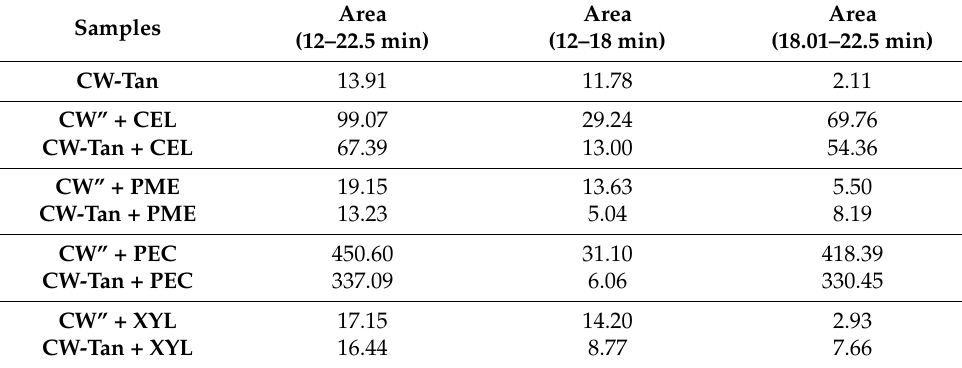
Table 6. Total area, height and medium molecular mass polysaccharides (those eluting from 12 to 18 min) and low to medium molecular mass polysaccharides (eluting from 18.1 to 22.5 min) measured in the size exclusion chromatography analysis for the polysaccharides liberated from the cell walls in the desorption